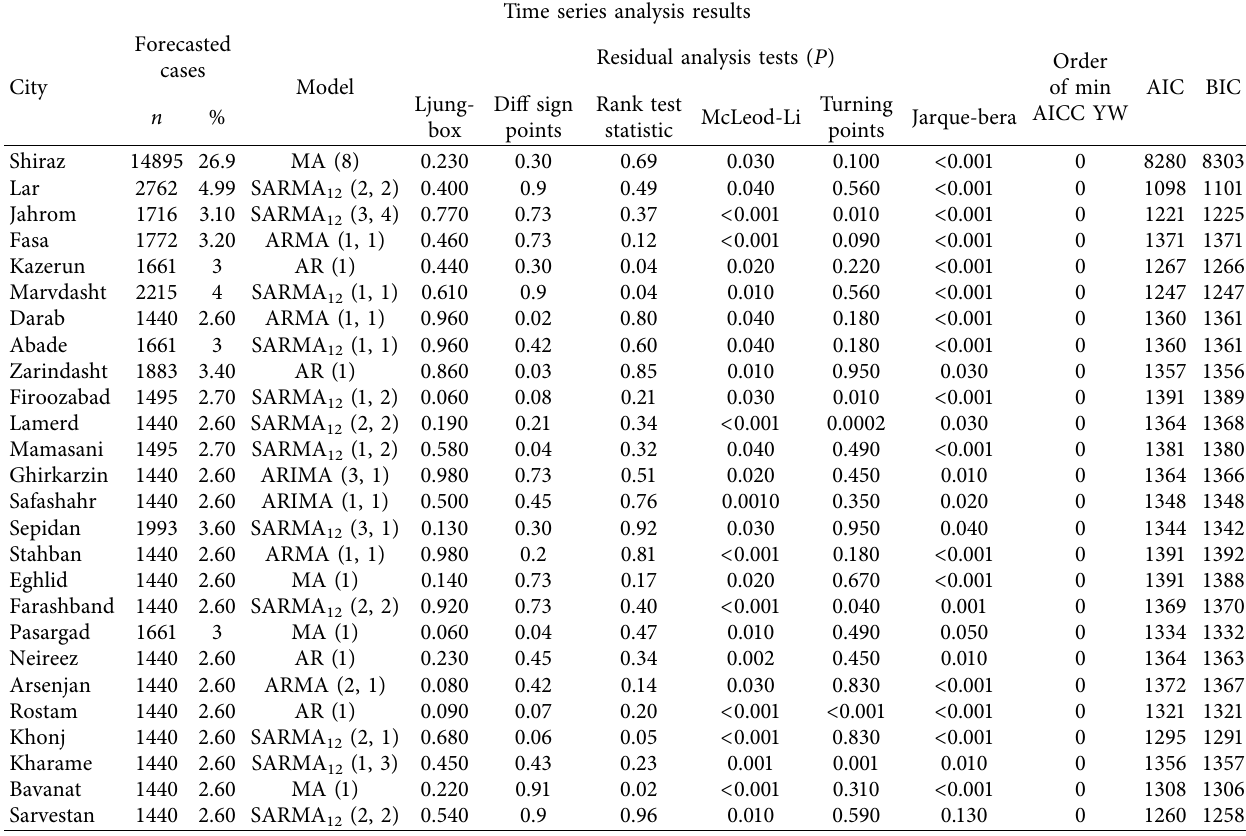
Table 5: The frequency 55 369 forecasted cases during 1 October–14 November 2020 accompanied by the results of time series analysis in the 26 cities of Fars province,